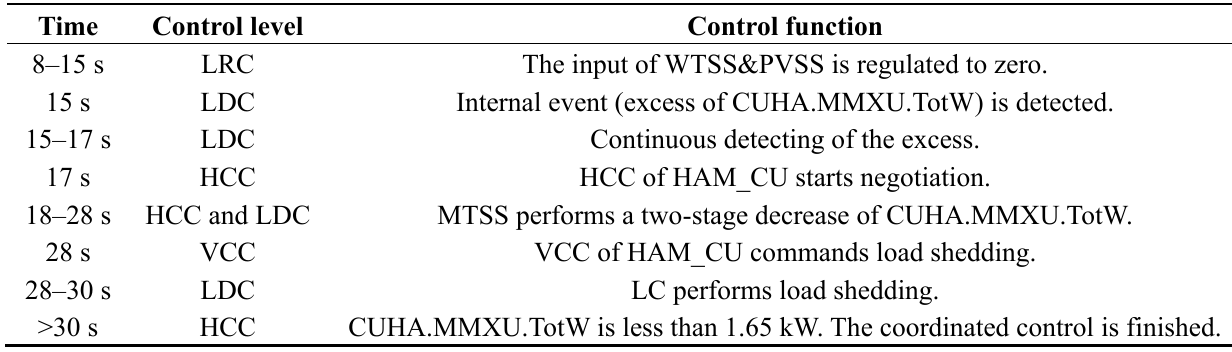
Table 3. Descriptions of Scenario IV.